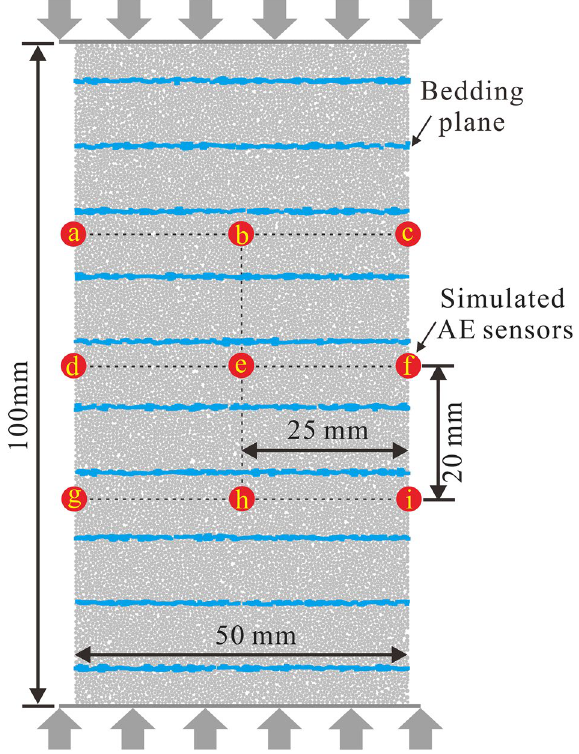
Figure 7. The layout of simulated AE sensors #a ~ #i on the numerical model. The axial and lateral spacing is 20 mm and 25 mm,